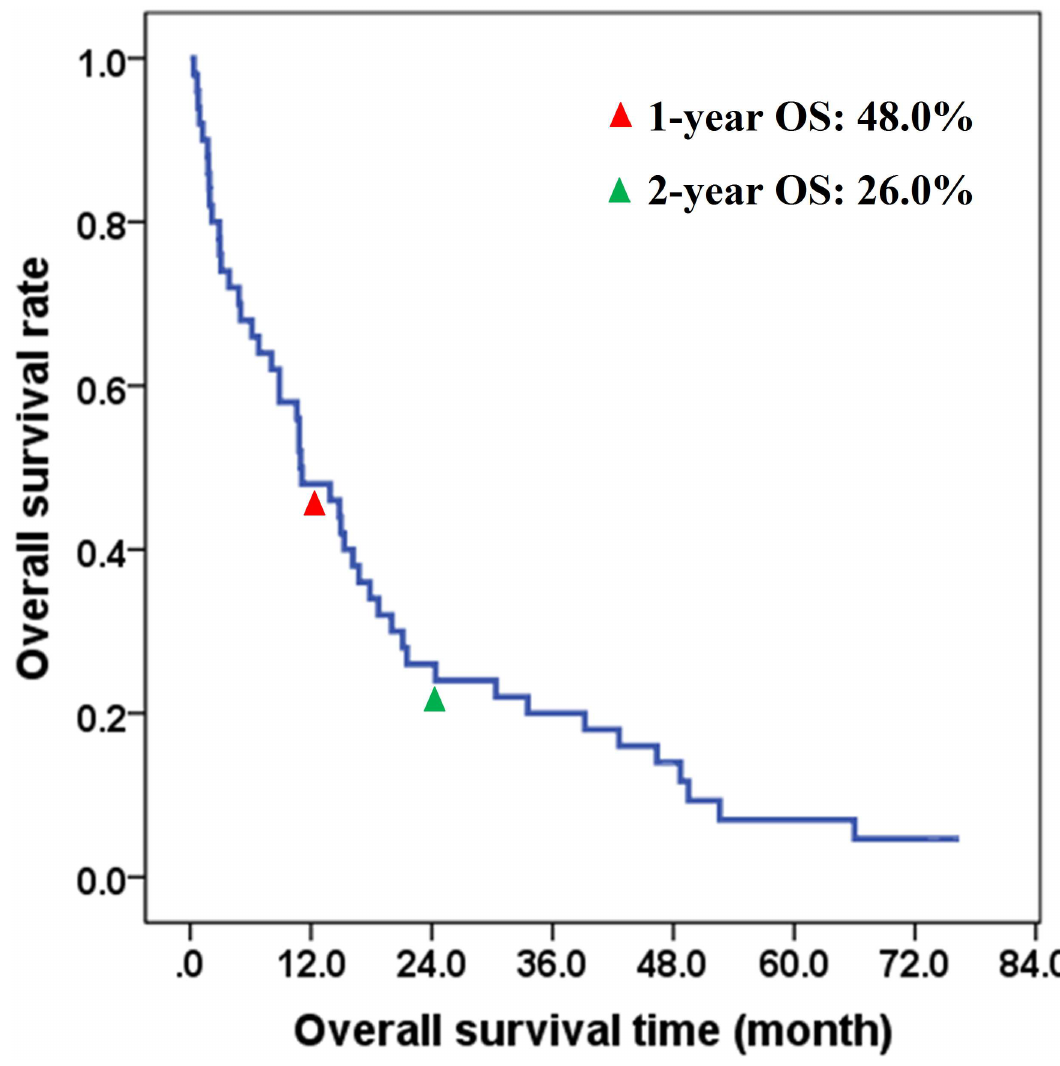
Fig 1. Overall survival of 50 ATC